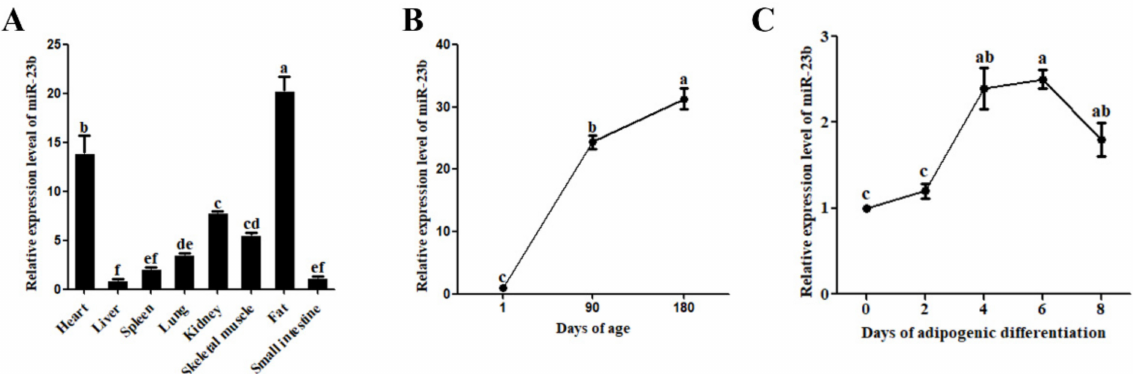
Figure 1. Expression patterns of miR-23b. ( A ) Expression analysis of miR-23b in various tissues of pigs; ( B ) expression analysis of miR-23b in pig adipose tissue at different developmental stages; ( C ) expression analysis of miR-23b during adipogenic differentiation of porcine precursor adipocytes. Note: Different lower-case letters of shoulder label indicated significant difference at 0.05